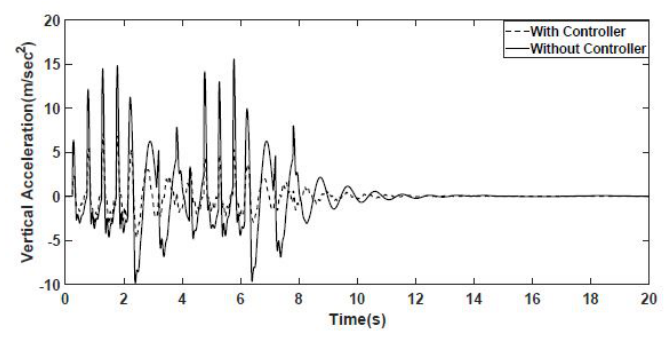
Figure 16. Pitch Displacement.